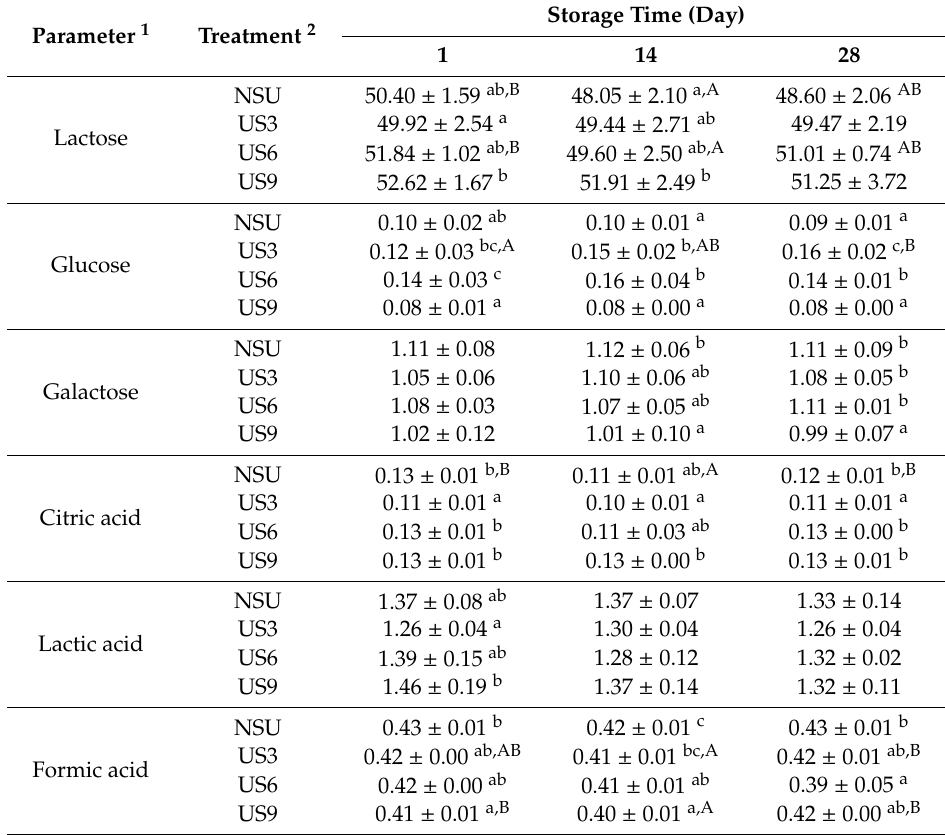
Table 2. Values of monosaccharides, disaccharides, and organic acids in goat milk yogurt samples measured during 28 days of storage at 4 ◦